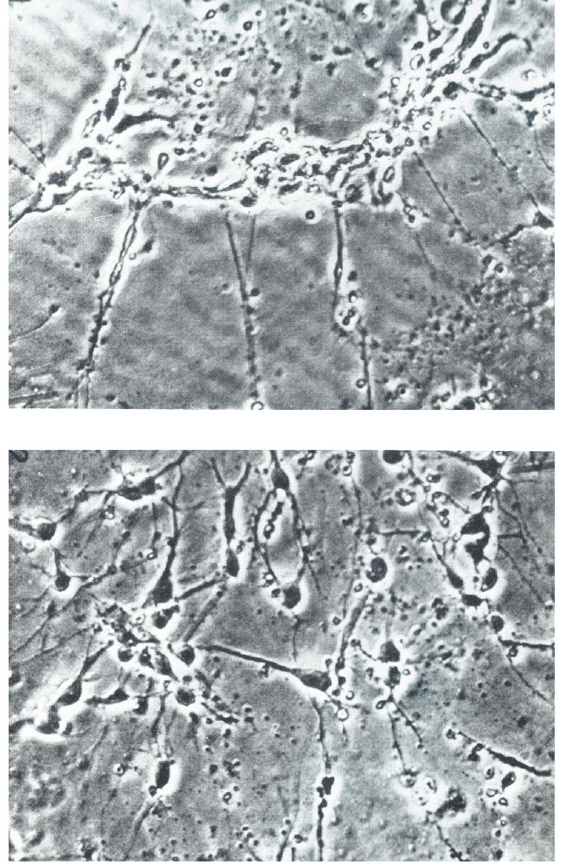
Figure 1. ( Top )—Control; ( Bottom )—Addition of 200 ng/mL of GHK to culture media (Phase contrast ×250, photo micrographs used with permission of John Wiley and Sons).